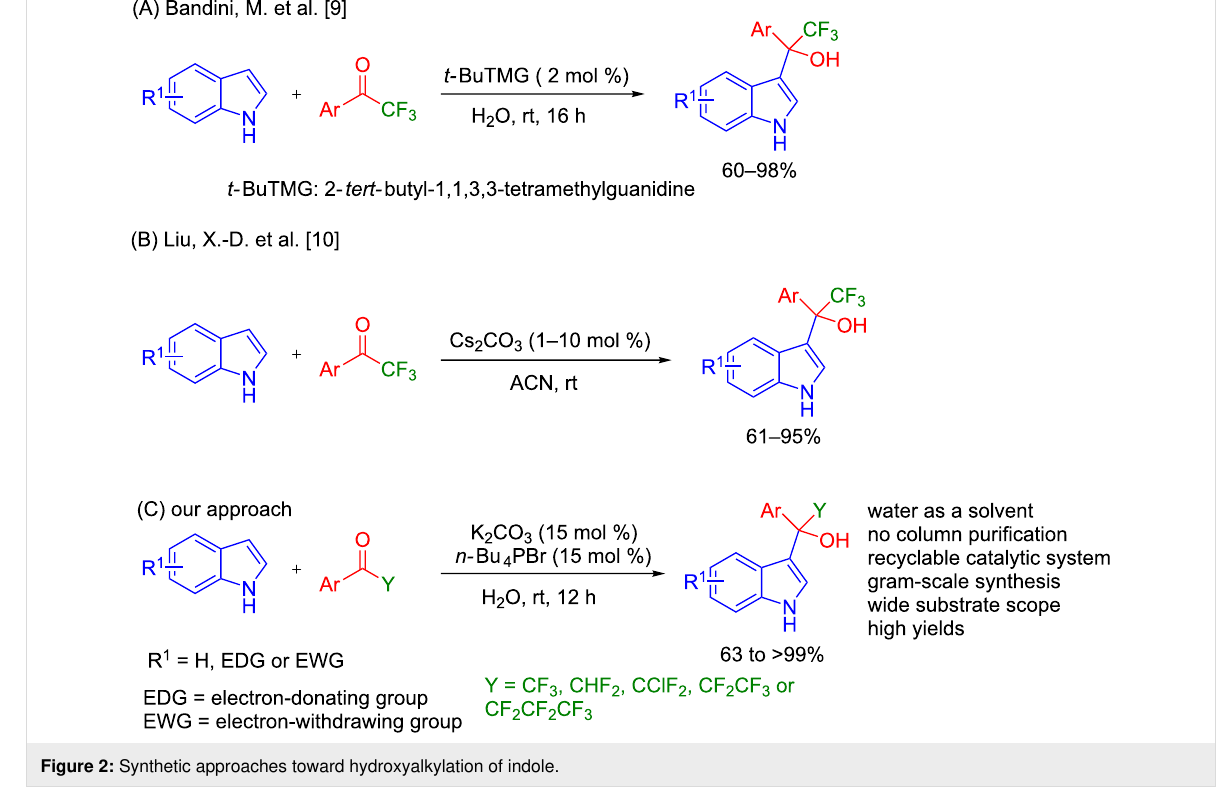
Figure 2: Synthetic approaches toward hydroxyalkylation of indole.